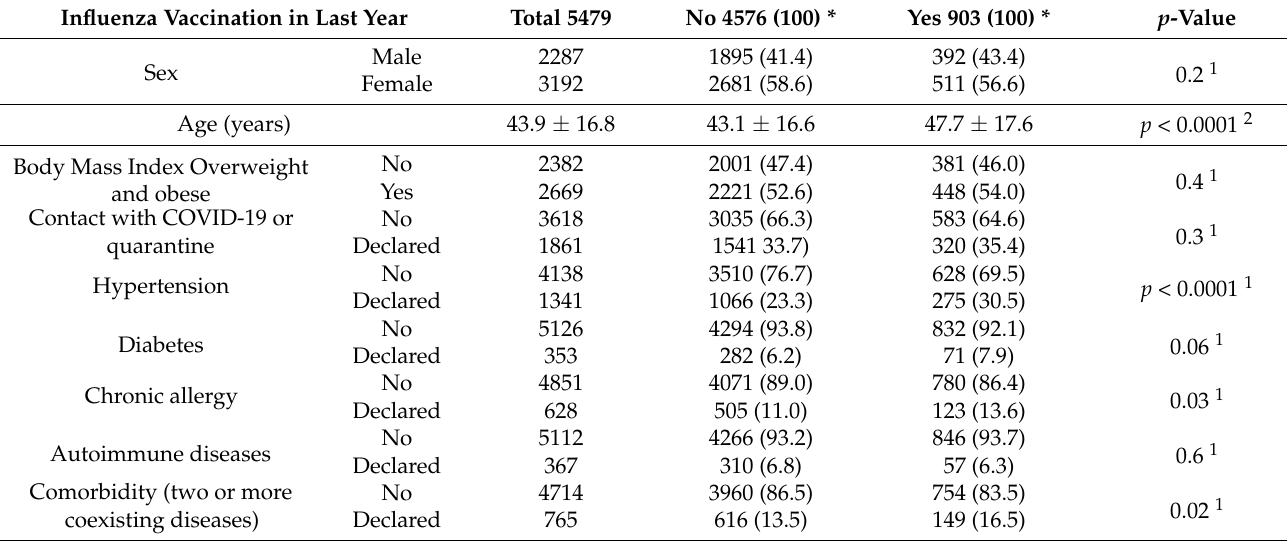
Table 1. Sex, age, COVID-19 related history, and the occurrence of chronic diseases, according to the influenza vaccination status (relative values in the